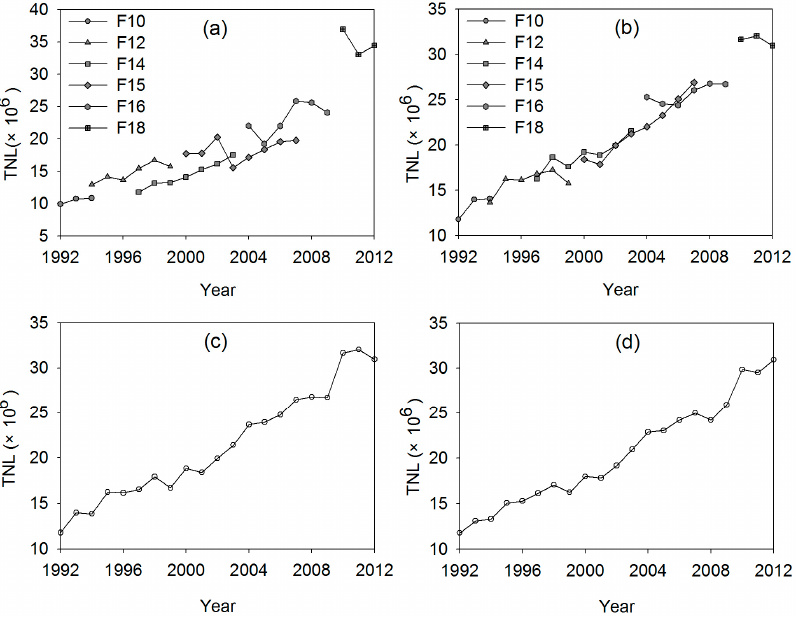
Figure 4. TNL of nighttime light images before and after correction. ( a ) Original images; ( b ) inter-calibration; ( c ) inter-annual composition; and ( d ) inter-annual series correction.